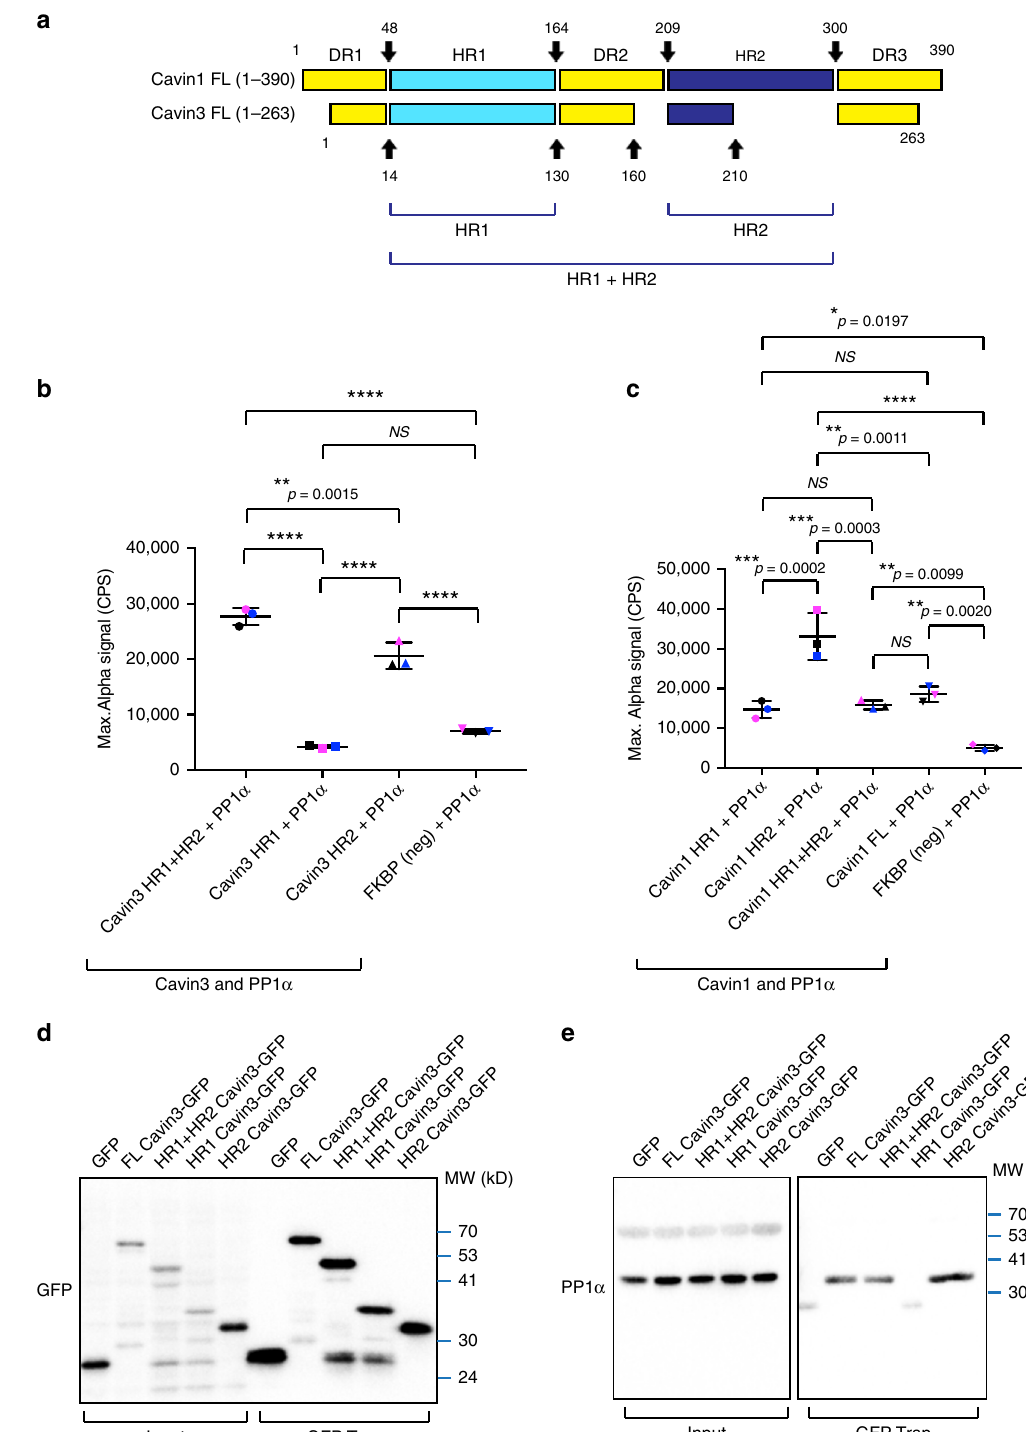
Fig. 3 PP1 α interacts with the HR2 domain of Cavin3 and Cavin1. a Schematic representation of the helical regions (HR)1 and HR2 regions of Cavin1 and Cavin3. b AlphaLISA screen of Cavin3 HR1 domain, Cavin3 HR2 domain, and Cavin3 HR1 + HR2 domain and PP1 α , FKBP, and PP1 α (negative control), ** p - value < 0.01, **** p -value < 0.0001 (one-way ANOVA). NS = no signi fi cance. Scatter dots in each group represent the values from three independent experiments (labeled by three colors). c AlphaLISA screen of Cavin1 HR1 domain and PP1 α , Cavin1 HR2 domain and PP1 α , Cavin1 HR1 + HR2 domain and PP1 α , Cavin1 FL and PP1 α , and FKBP and PP1 α (negative control), * p -value < 0.05, ** p -value < 0.01, *** p -value < 0.001, **** p -value < 0.0001